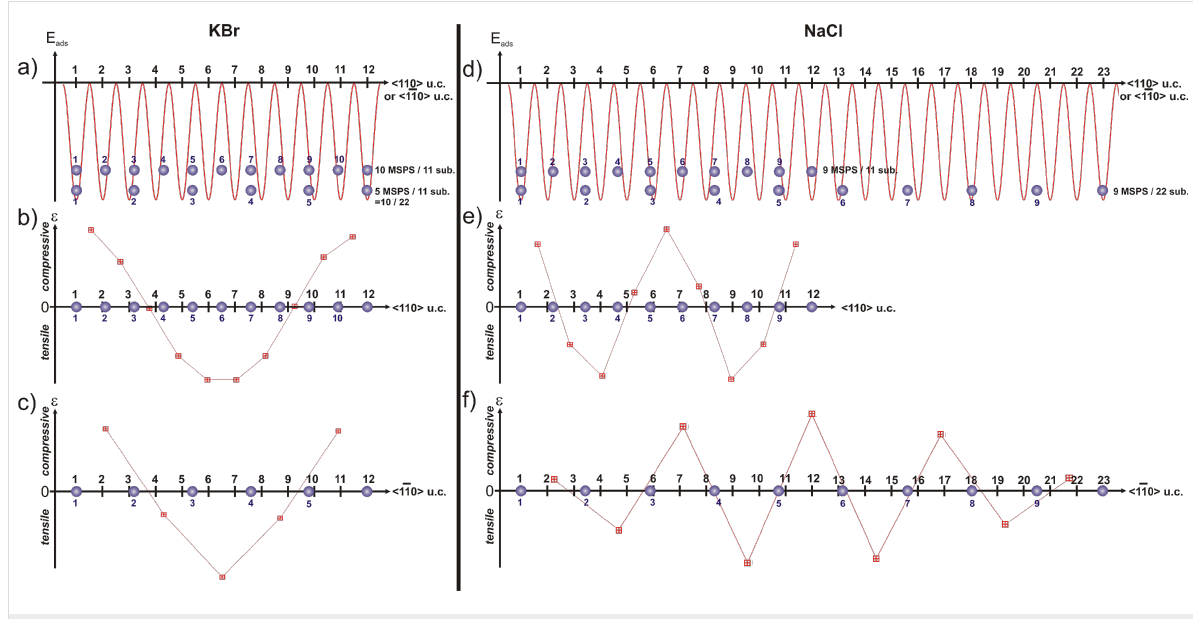
Figure 5: Model for the lateral stress ε in a MSPS film adsorbed on KBr (left) and NaCl (right). (a) and (d) display the position of the adsorbed mole- cule with respect to the sinusoidally shaped E ads potential; (b) and (e) indicate if there is tensile or compressive stress within the film along the short molecular axes a 1 m (i.e., the direction), and (c) and (f) along the long molecular axes a 2 m (